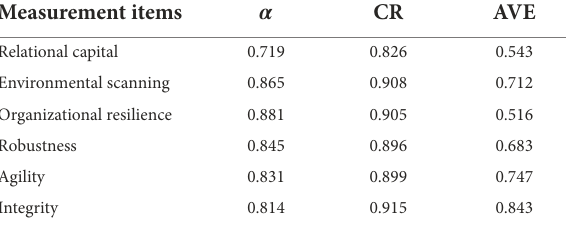
TABLE 2 Variables’ reliability and